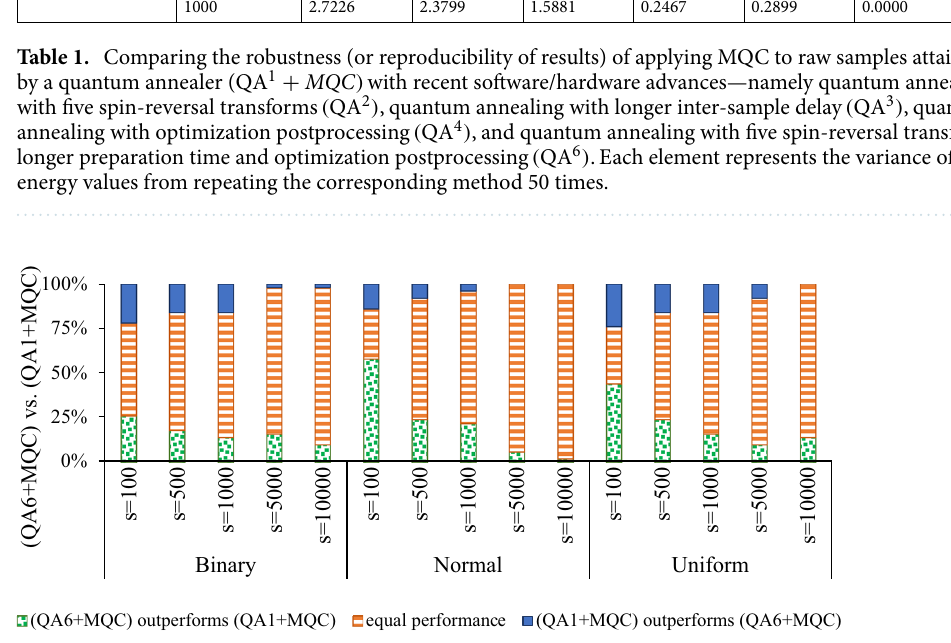
Figure 4. Comparing the performance of applying MQC to raw samples attained by a quantum annealer ( QA 1 + MQC ) with applying MQC to samples attained by the quantum annealing with five spin-reversal transforms, longer preparation time and optimization postprocessing ( QA 6 + MQC ) where s denotes the number of